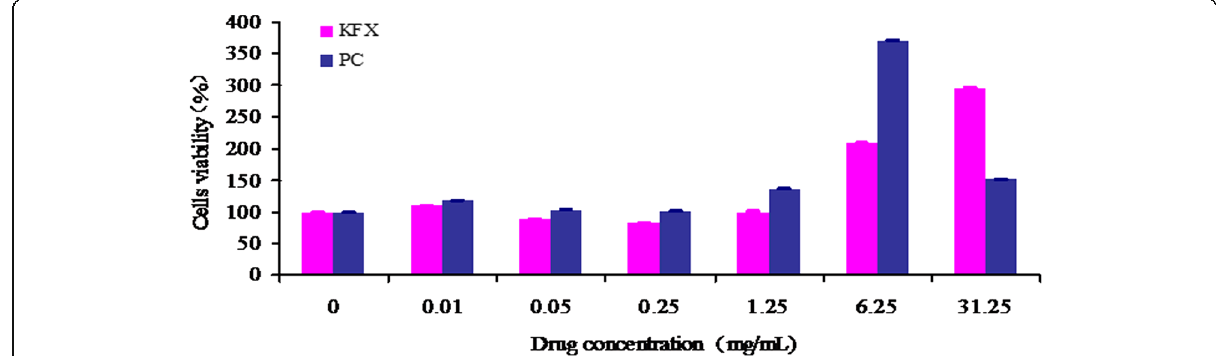
Fig. 7 Cell viability assay (MTT assay) in BMSCs incubated with KFX and positive control in a dose-dependent manner for 24 h. KFX (1.25, 6.25, 31.25 mg/mL) and PC (1.25, 6.25, 31.25 mg/mL) drug have expressed an upward trend in BMSCs proliferation, compared with that of blank control group. Data are means ± SD of six independent experiments and statistical significance was calculated by using t -test (* represents * p < 0.05,** p <